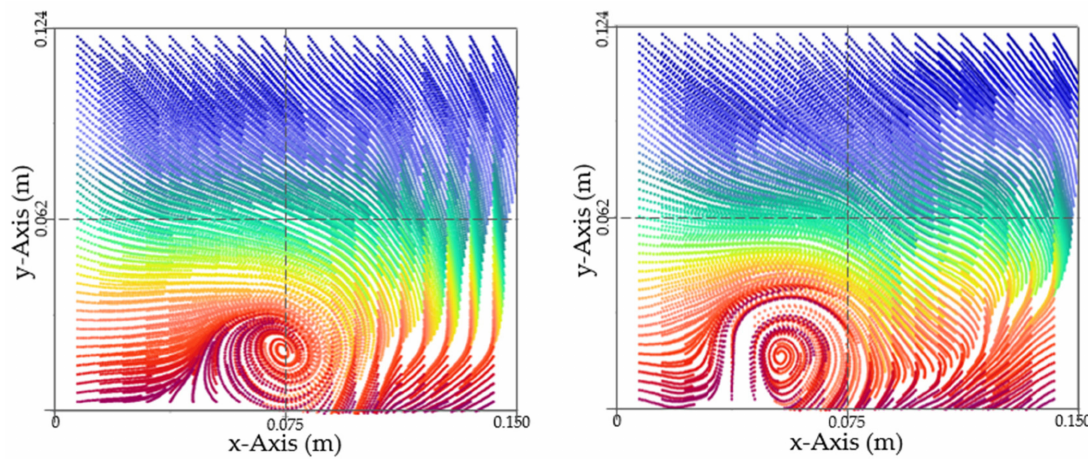
Figure 4. Motion of the Type 2 subsurface vortex (streak line results of PIV